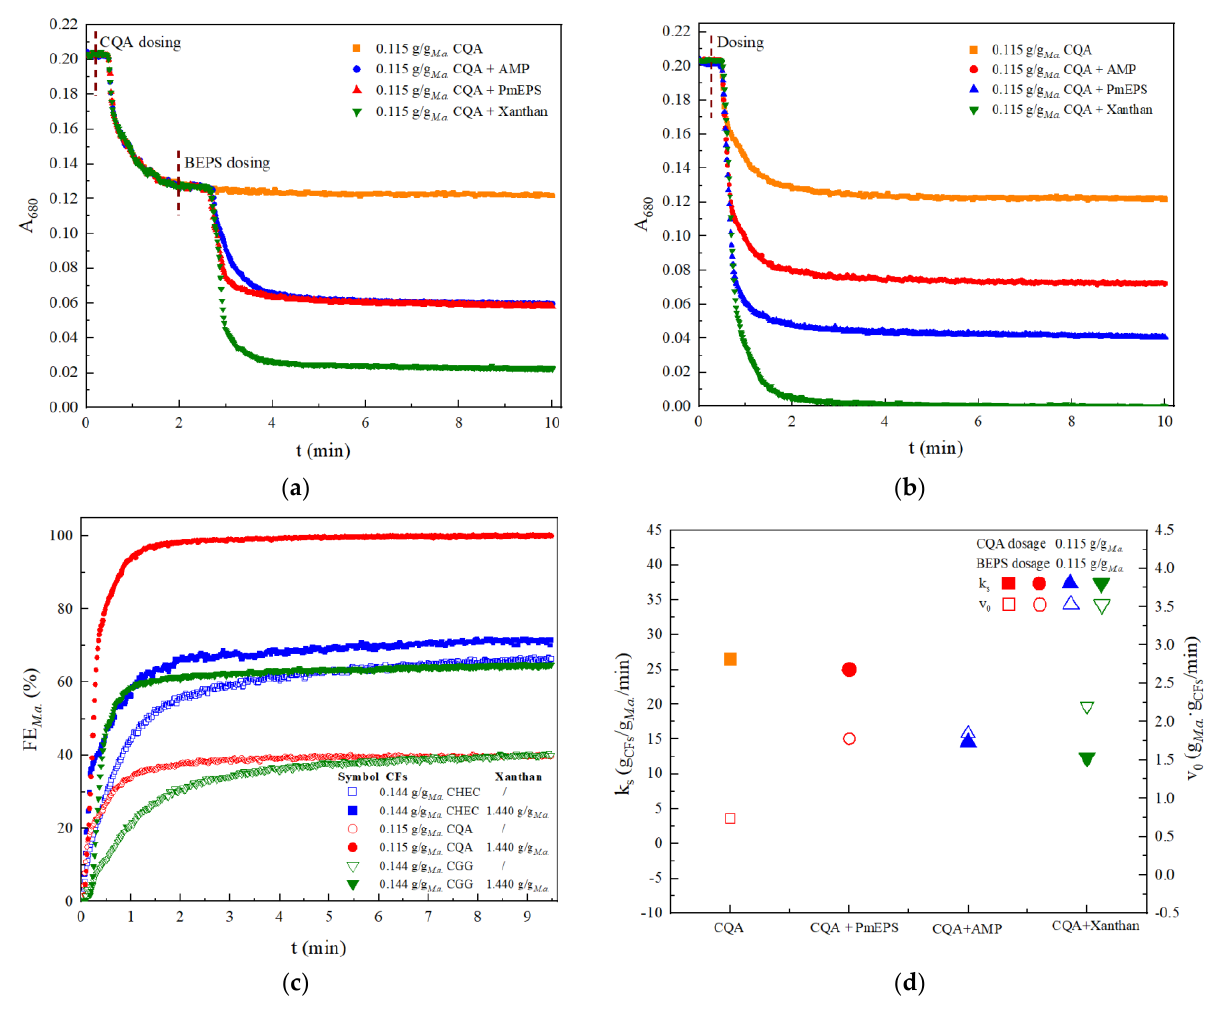
Figure 4. TR kinetic profiles of M. aeruginosa coagulation by PBCFs combinations: ( a ) Stepwise addition; ( b ) Simultaneous addition; ( c ) Flocculation efficiency; ( d ) k s and v 0 deduced from pseudo-second-order model .